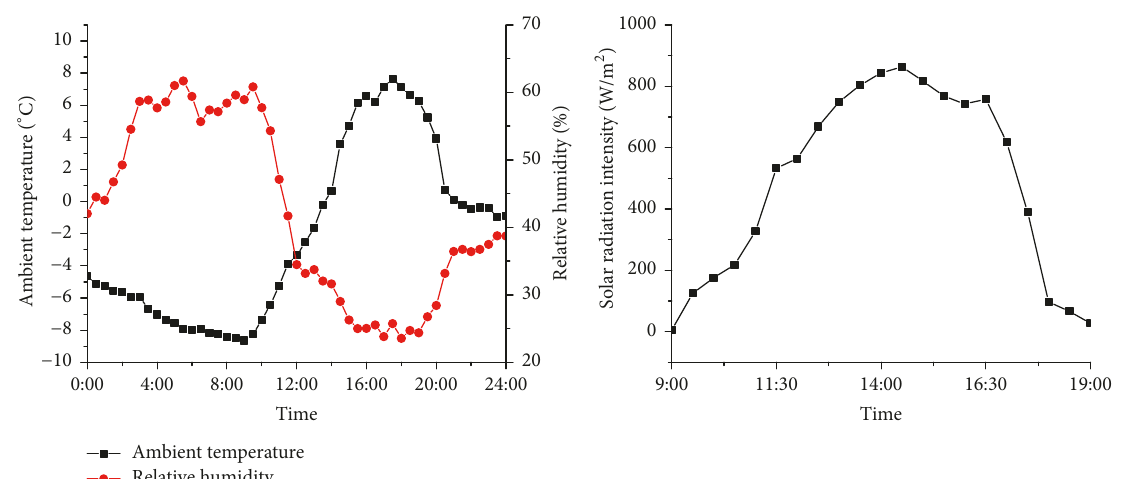
Figure 6: Outdoor meteorological